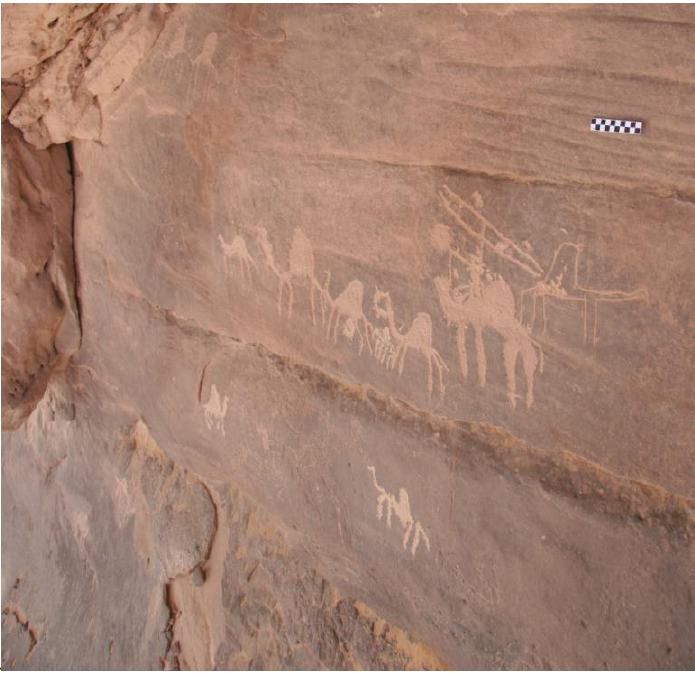
Figure 7. Caravan in Camel style along the rock wall of Ti-n-Abrukin